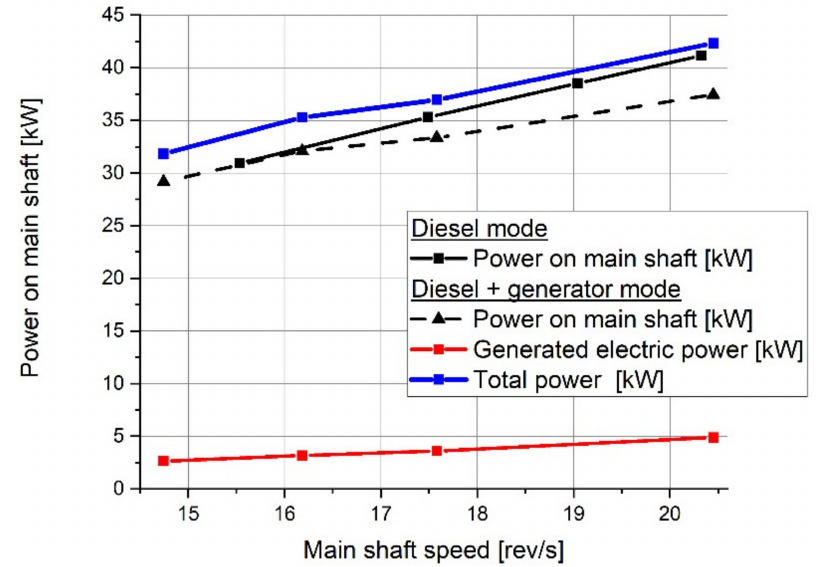
Figure 11. Power on the main shaft and electric power generated in diesel plus generator mode.